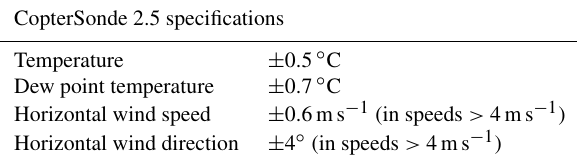
Table 2. Summary of CopterSonde measurement specifications based on the results of this study when compared to the Vaisala RS92-SGP data used in this